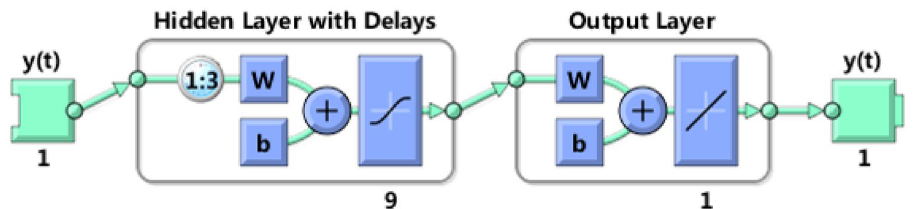
Figure 6. The frame structure of the PCA–RVM–NAR model, where the input is the residual of the PCA–RVM model. This network has 1 inputs, 1 hidden layer with 9 hidden neurons, 3 input delay orders, and 1 linear output layer leading to 1